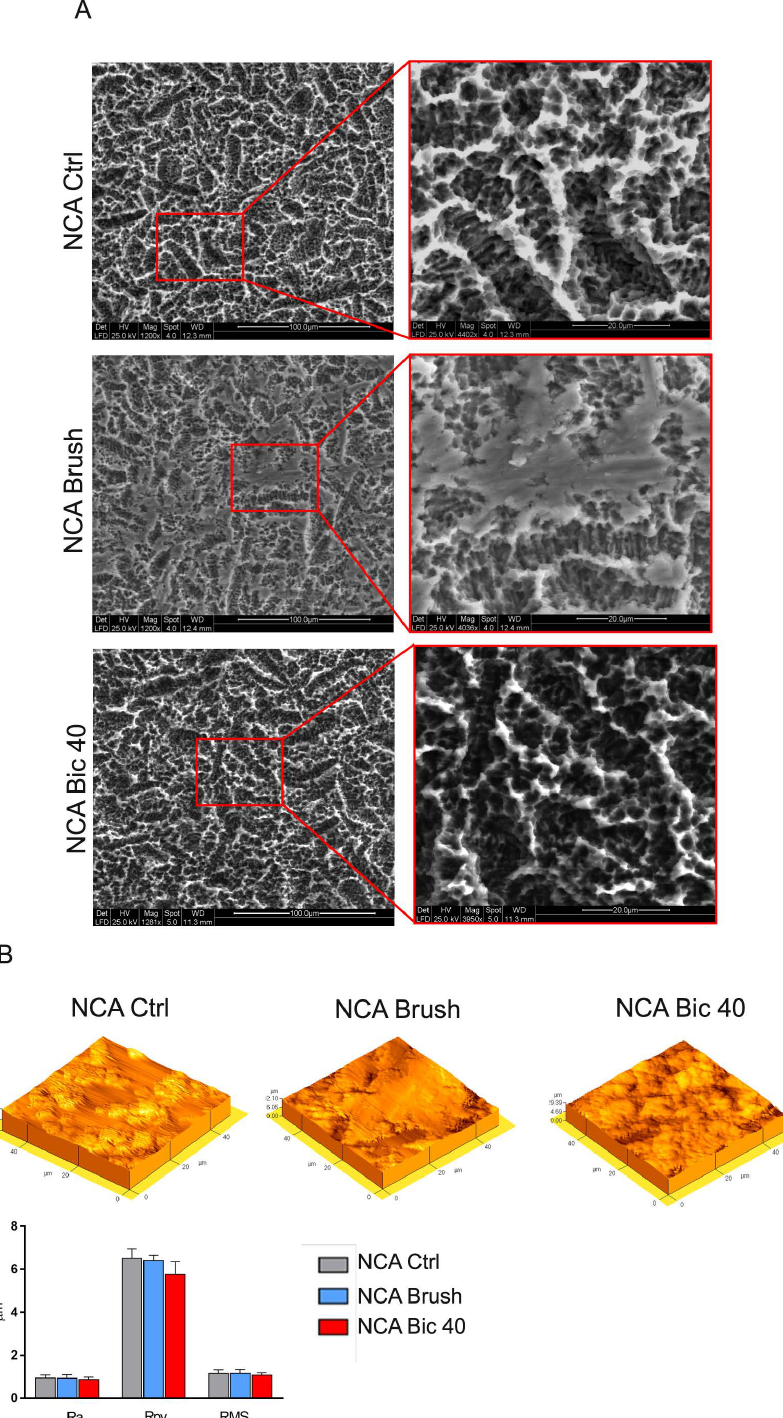
Figure 2. NCA surfaces characterization after cleansing treatments. ( A ) SEM analysis at di ff erent magnificationswascarriedoutonNCAtitaniumsurfacesfromthethreeexperimentalgroups(Ctrl,Brush and Bic40, as indicated) in order to evaluate the surface topography. Scale bars: 100 µ m (left) and 20 µ m (magnifications on the right). ( B ) AFM analysis of NCA surfaces. Histograms report the surface roughness expressed as Ra, Rpv and Rsm values. Values represent mean ± SD of three independent experiments. No statistically significant di ff erence was detected among the groups; one-way ANOVA followed by the Newman-Keuls post-hoc